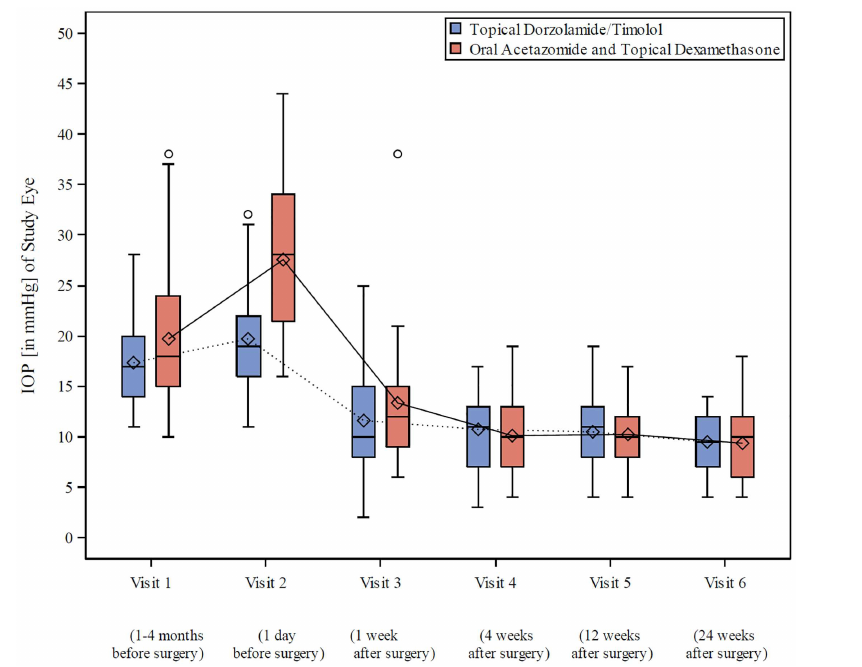
Fig 2. IOP (in mmHg) of the studied eye across visits–PP population (n = 62).